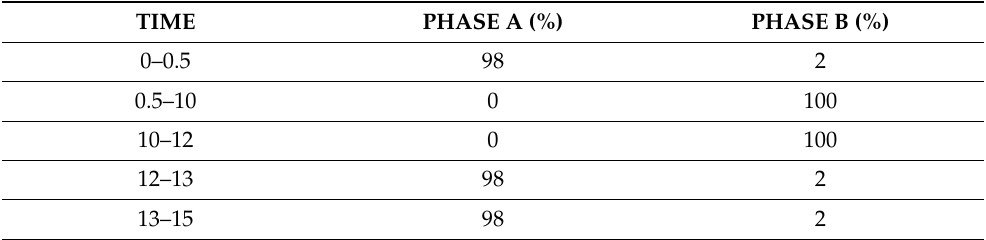
Table 1. UHPLC elution